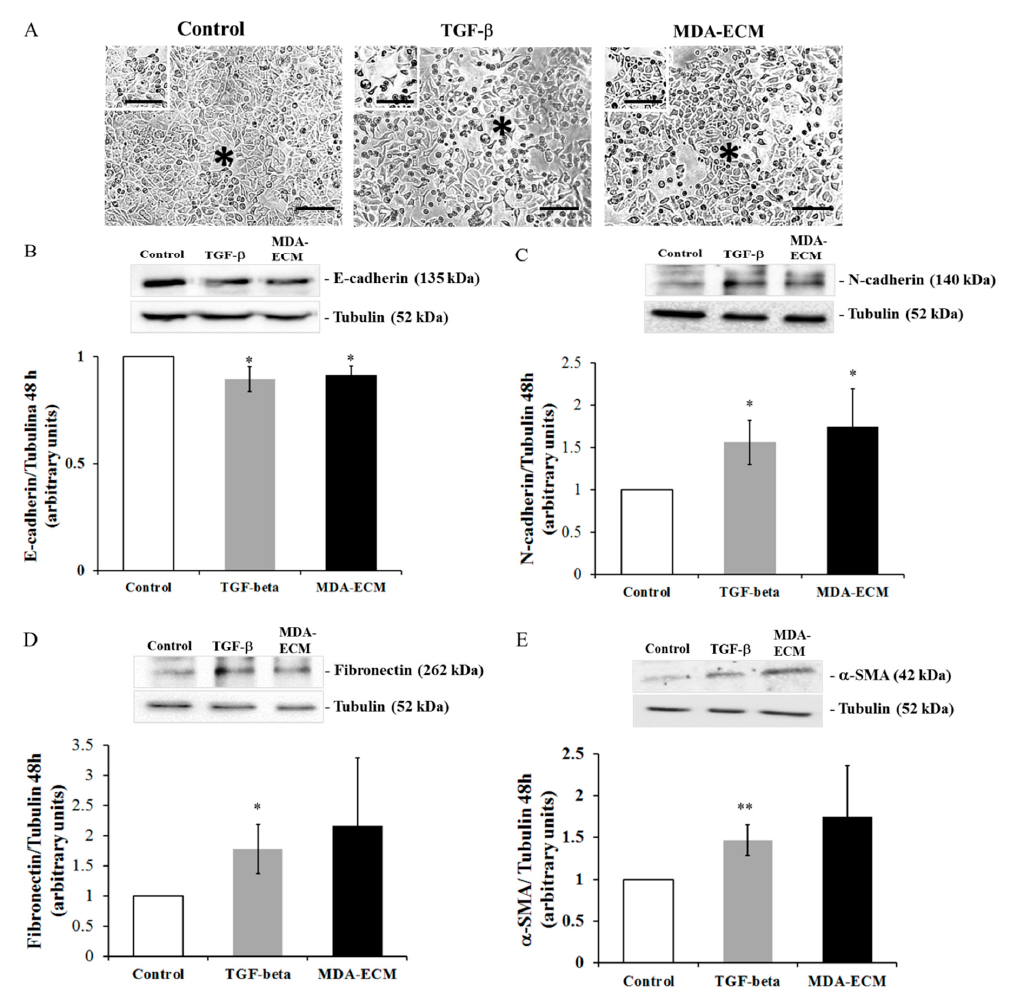
Figure 2. MDA-MB-231-derived ECM promoted a slight decrease in E-cadherin expression in MCF-7 cells in 48 h. MCF-7 and MDA-MB-231 cells were cultured in standard conditions for 48 h, and decellularized ECMs were obtained, as described in Methods. MCF-7 cells were cultured onto MDA-ECM or onto their own matrix with TGF- β 1 (10 ng/mL) for 48 h. ( A ) Cell morphology was analyzed, and representative images were obtained at 40× magnification. A black asterisk indicates lost or remaining intercellular connections. Scale bar: 20 µm ( B – E ) Lysates of MCF-7 cultured as described for 48 h were immunoblotted with anti-N-cadherin ( B ), anti- α -SMA ( C ), anti-fibronectin ( D ), and anti-E-cadherin ( E ) antibodies. The results are shown as the mean fold increase relative to the control (MCF-ECM), and bars represent the mean ± SD calculated from 3 individual experiments (* p < 0.05 and ** p < 0.01).